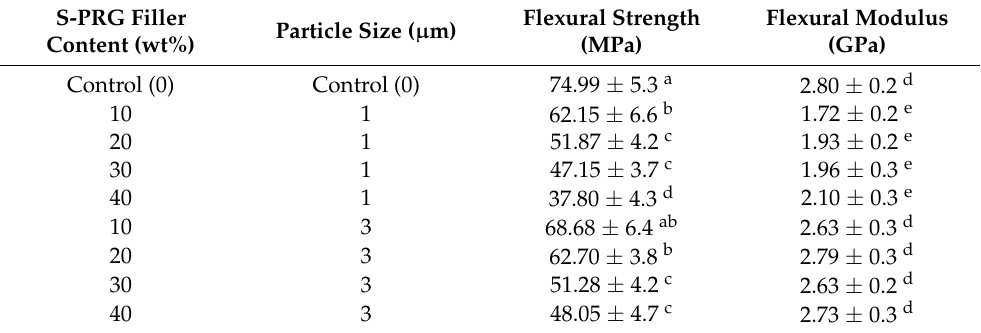
Figure 2. Flexural strength. The bars represent mean values ± standard deviation ( n = 12). Different letters indicate statistical significance ( p < 0.05). Table 1. Flexural strength and flexural modulus values of specimens (control, S-PRG-1, and S-PRG-3).